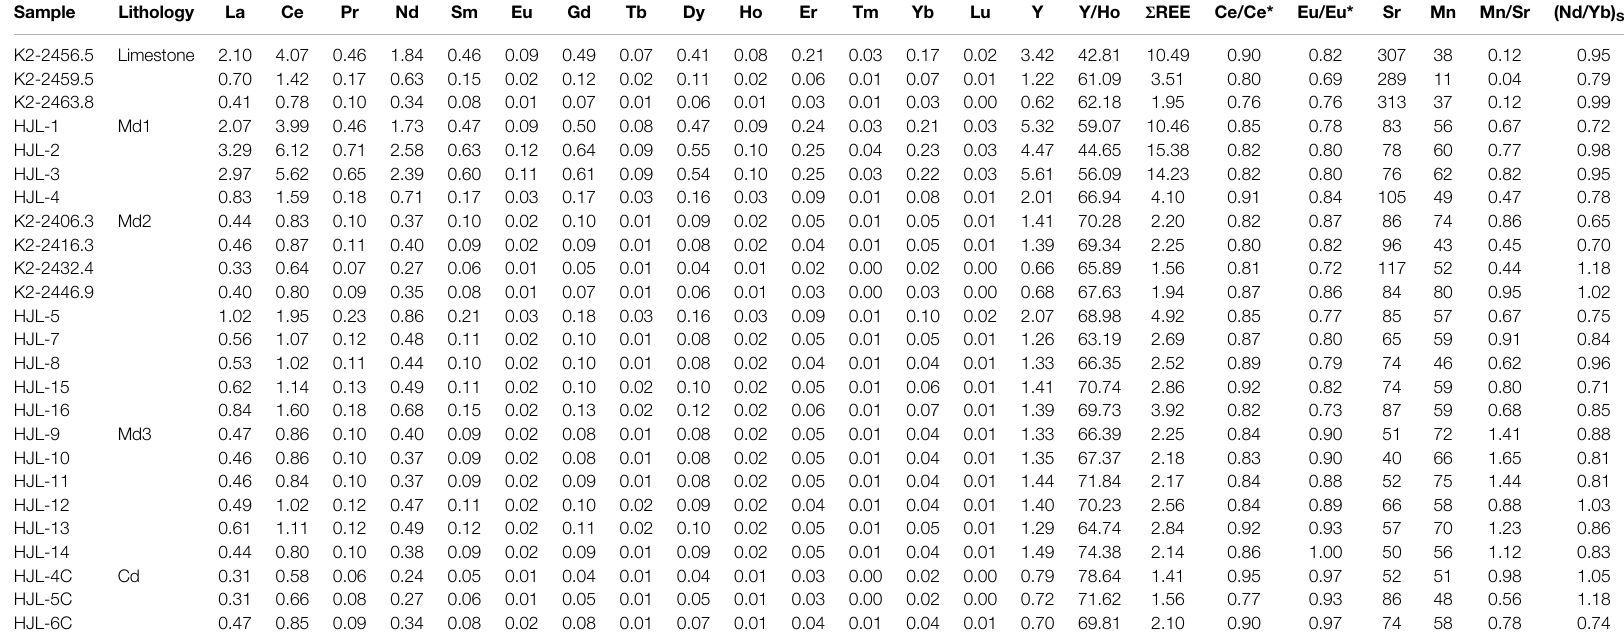
TABLE 2 | Major and trace elements data for Middle Permian carbonates of the northwestern (NW) study area (10 − 6 mg/g). Sample